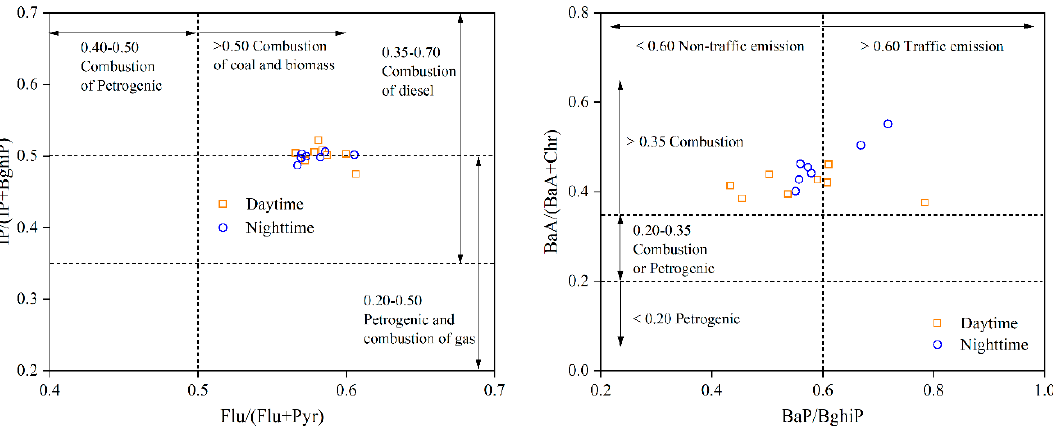
Figure 6. Variation in Flu/(Flu + Pyr) and IP/(IP + BghiP), BaP/BghiP and BaA(BaA + Chr) during the monitoring period.